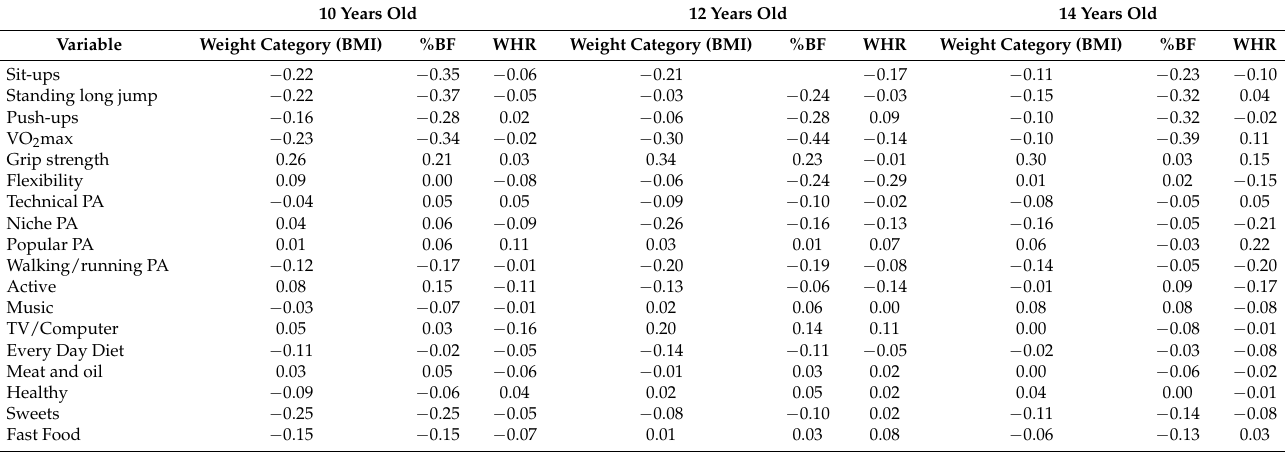
Table 5. Correlation coefficients calculated for all variables for 10-, 12- and 14-year-old children. Bold and enlarged numbers indicate the statistical significance at p <